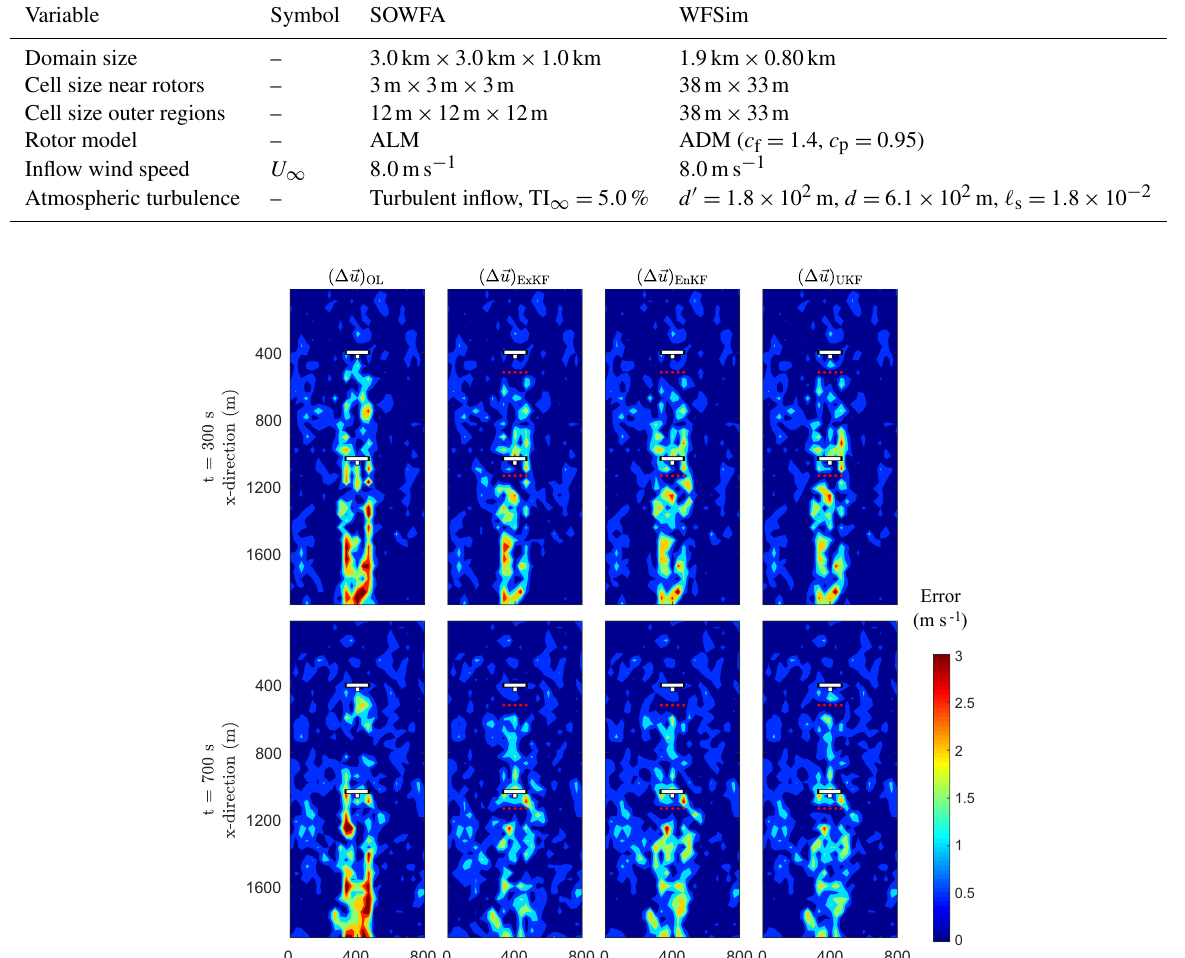
Table 1. Overview of several settings for the SOWFA and the WFSim two-turbine wind farm simulation. Variable